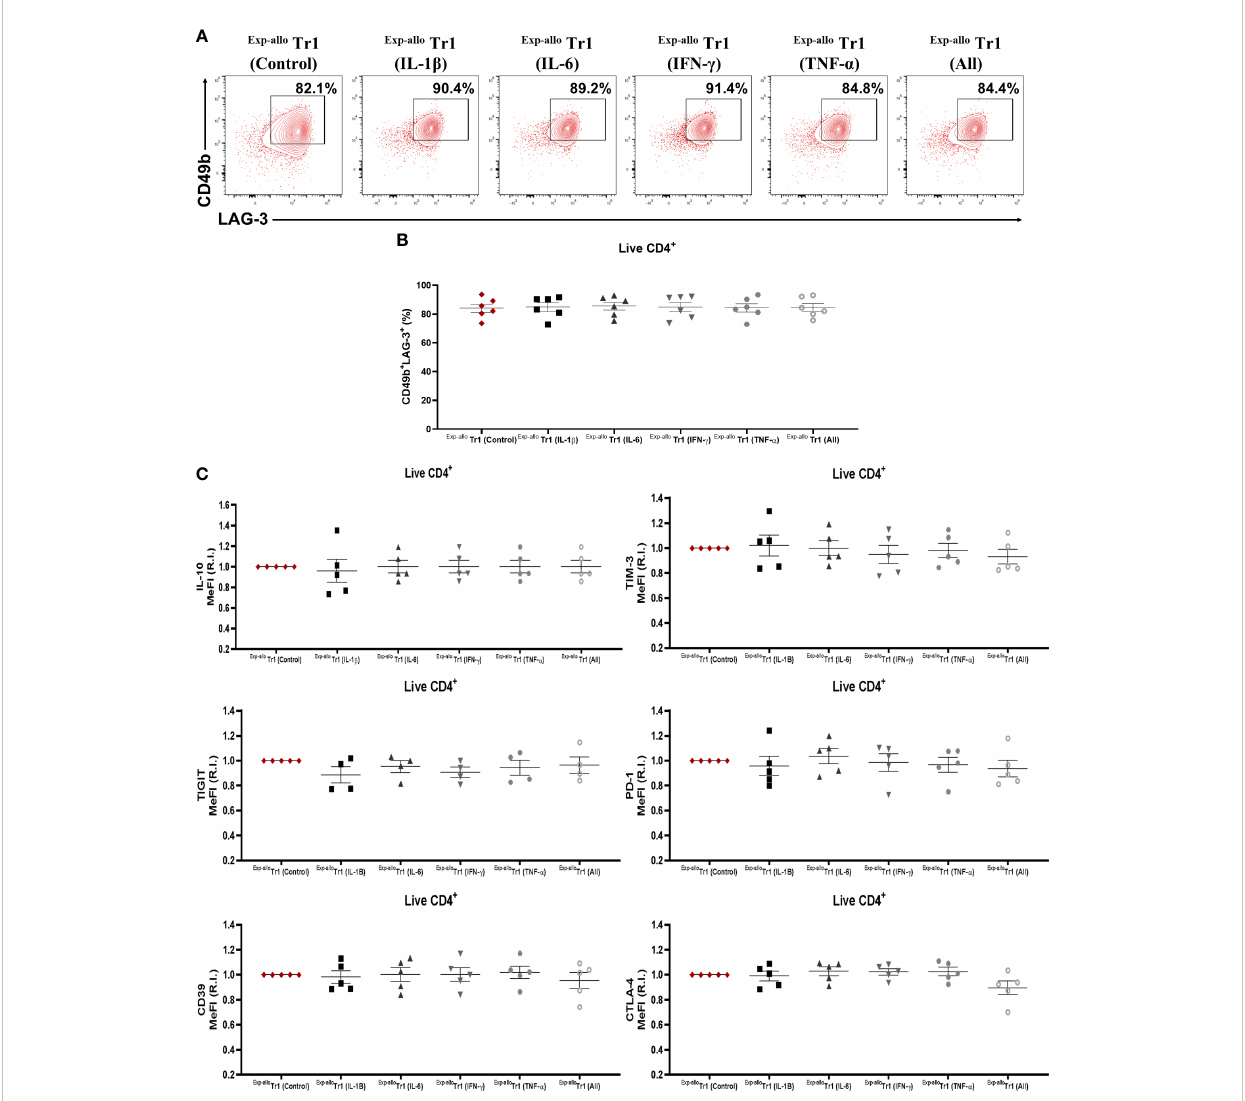
FIGURE 10 Exp-allo Tr1 cells maintain their immunosuppressive phenotype after stimulation in an in fl ammatory microenvironment. Exp-allo Tr1 cells were stimulated with anti-CD3/anti-CD28 in the presence or absence of pro-in fl ammatory cytokines (IFN- g , IL-6, IL-1 b , TNF- a or all together) for two additional weeks. (A) Representative contour-plot of CD49b and LAG-3 expression in Exp-allo Tr1 activated in presence of in fl ammatory cytokines. (B) Proportion of CD49b + LAG-3 + expression in Exp-allo Tr1 cells activated in presence or absence of in fl ammatory cytokines (n= 5). (C) Relative increase (IR) of IL-10, TIM- 3, TIGIT, PD-1, CD39 and CTLA-4 (MeFI). RI was calculated by dividing the value of all the conditions by the value of control Exp-allo Tr1 condition. All experiments were performed in duplicates. Data are representative offour independent experiments. The results are shown as mean ± SEM. Statistical analysis was performed using the unpaired-t test or one sample t and Wilcoxon test. No signi fi cant differences were